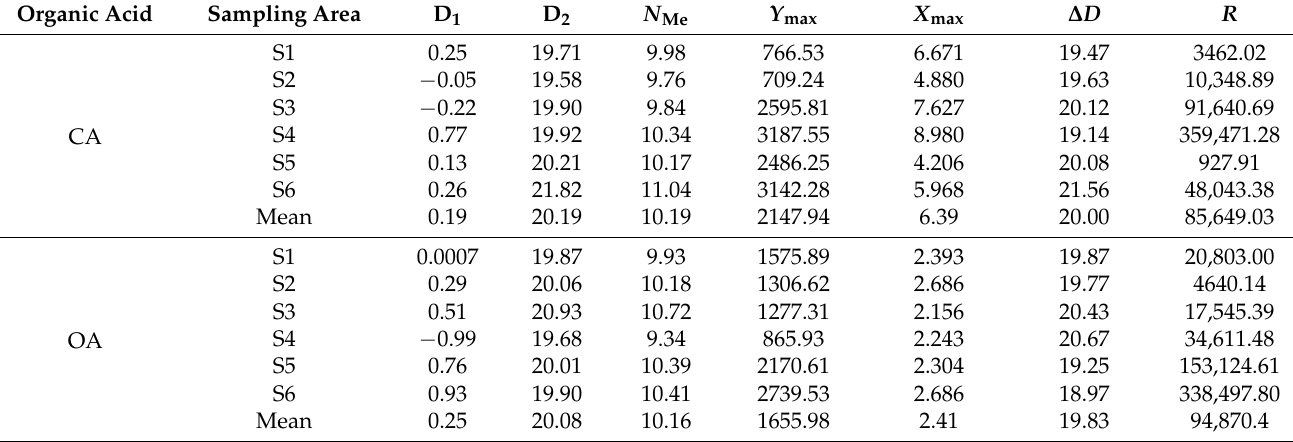
Table 4. Hormetic parameters of the P extraction efficiency of different types of LMWOAs. Organic Acid Sampling